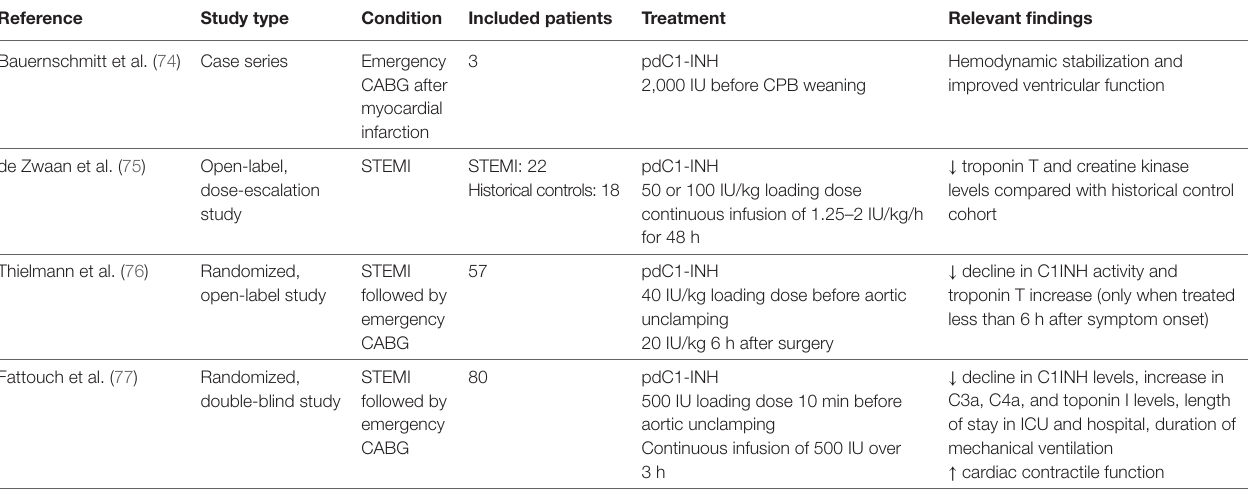
TABLe 4 | Effect of C1INH in clinical trials of